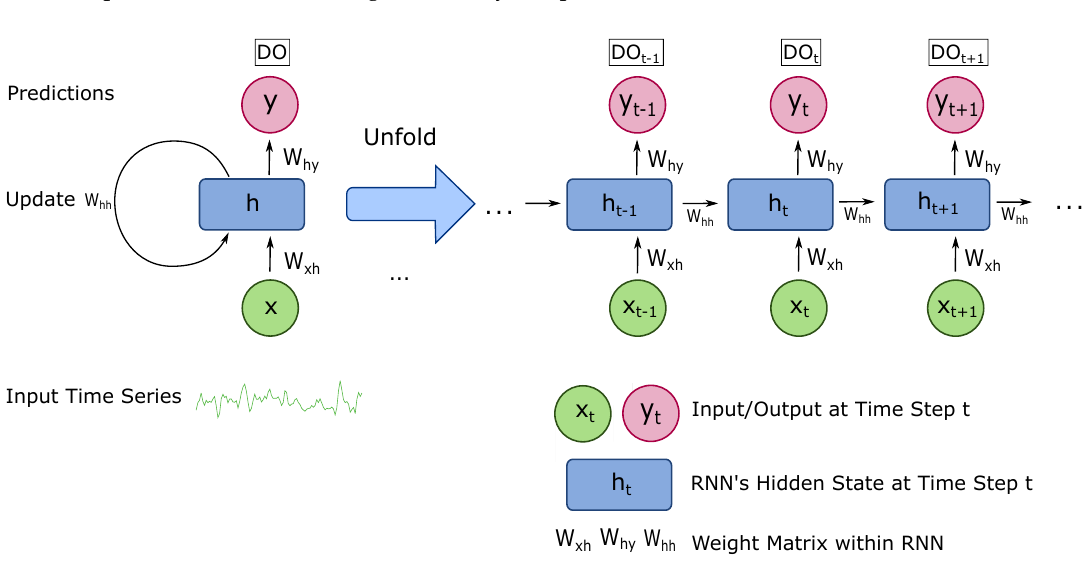
Figure 5. Recurrent neural network for predicting